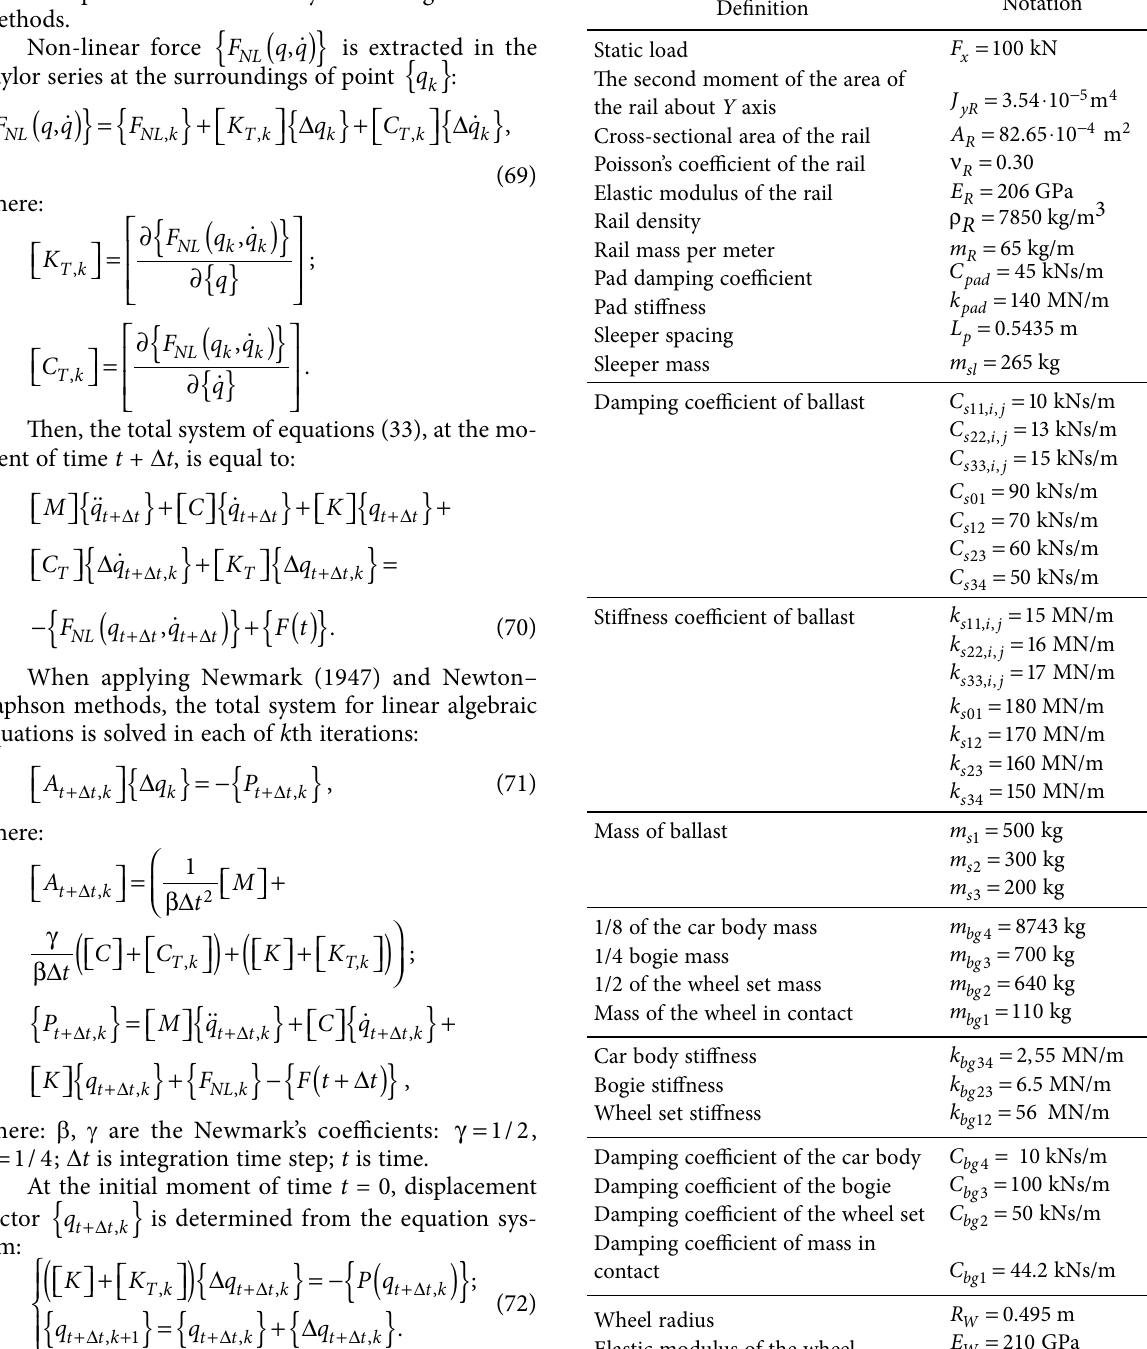
Table 1. Data calculation. Track and vehicle system